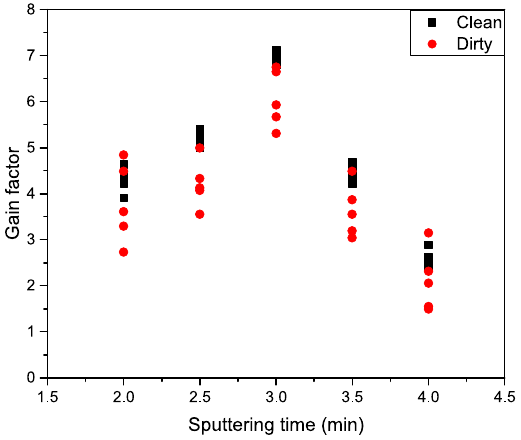
Figure 4. The gain change during sputtering in dSIMS mode for As dopant in Si substrate measured at five different spots for a clean and a dirty sample. For the cleaned sample, the method is reproducible, with small variations only.